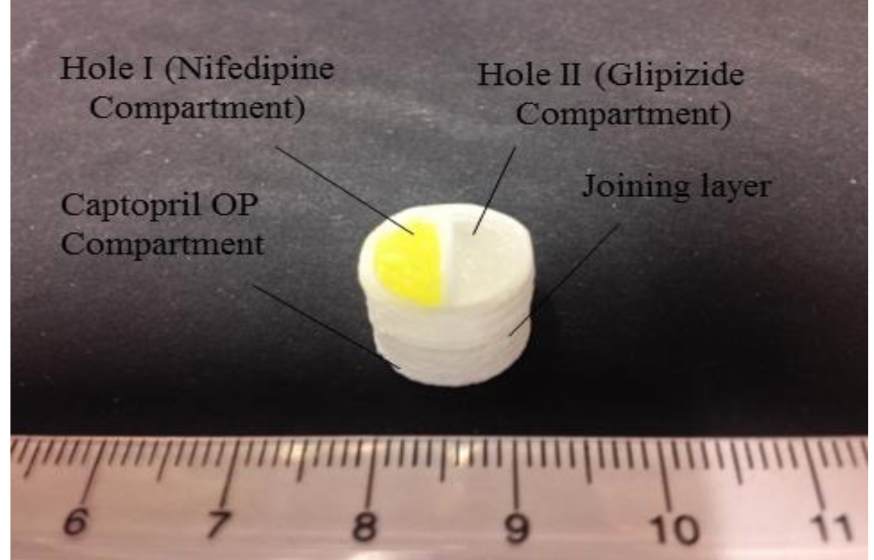
Figure 13. Image of a multiactive tablet (10.45 mm (height) × 6 mm (radius)) composed of a captopril osmotic pump compartment (bottom), and nifedipine- (hole I) and glipizide (hole II)-sustained release compartments (top), as well as a joining layer